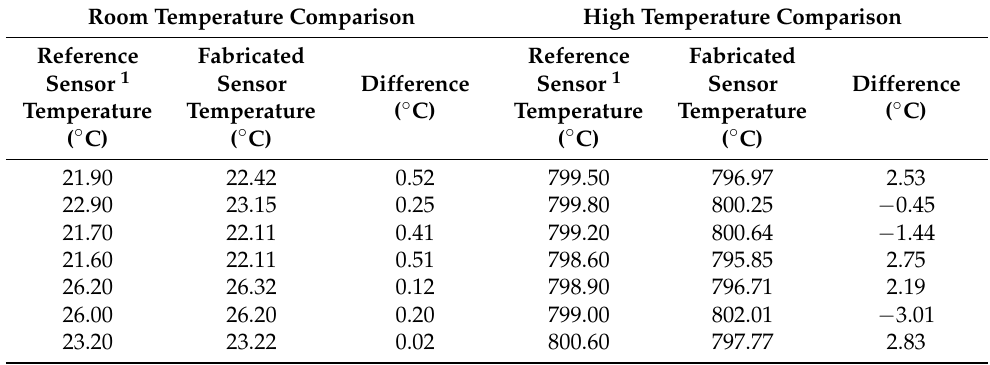
Table 1. Comparison of temperature measurement by our sensor and a reference thermocouple. Room Temperature